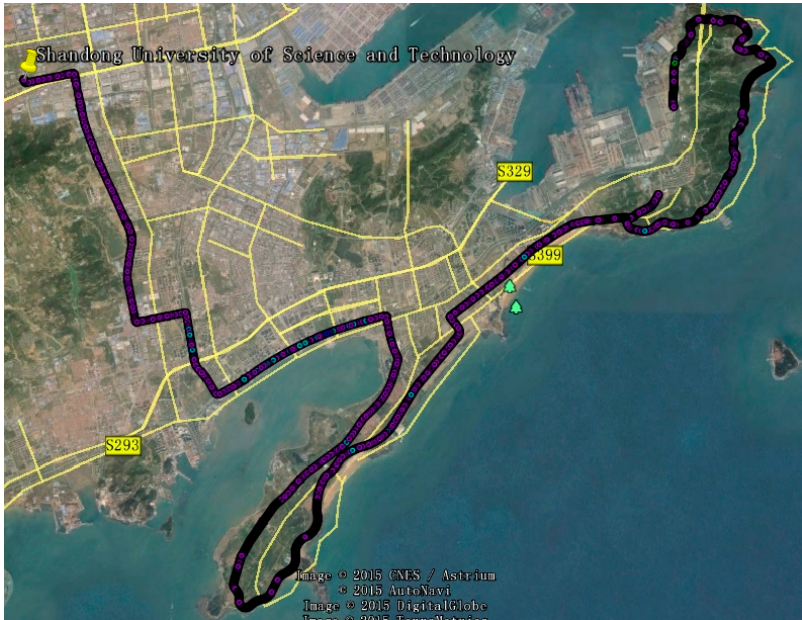
Figure 14. The trajectory of this experiment.